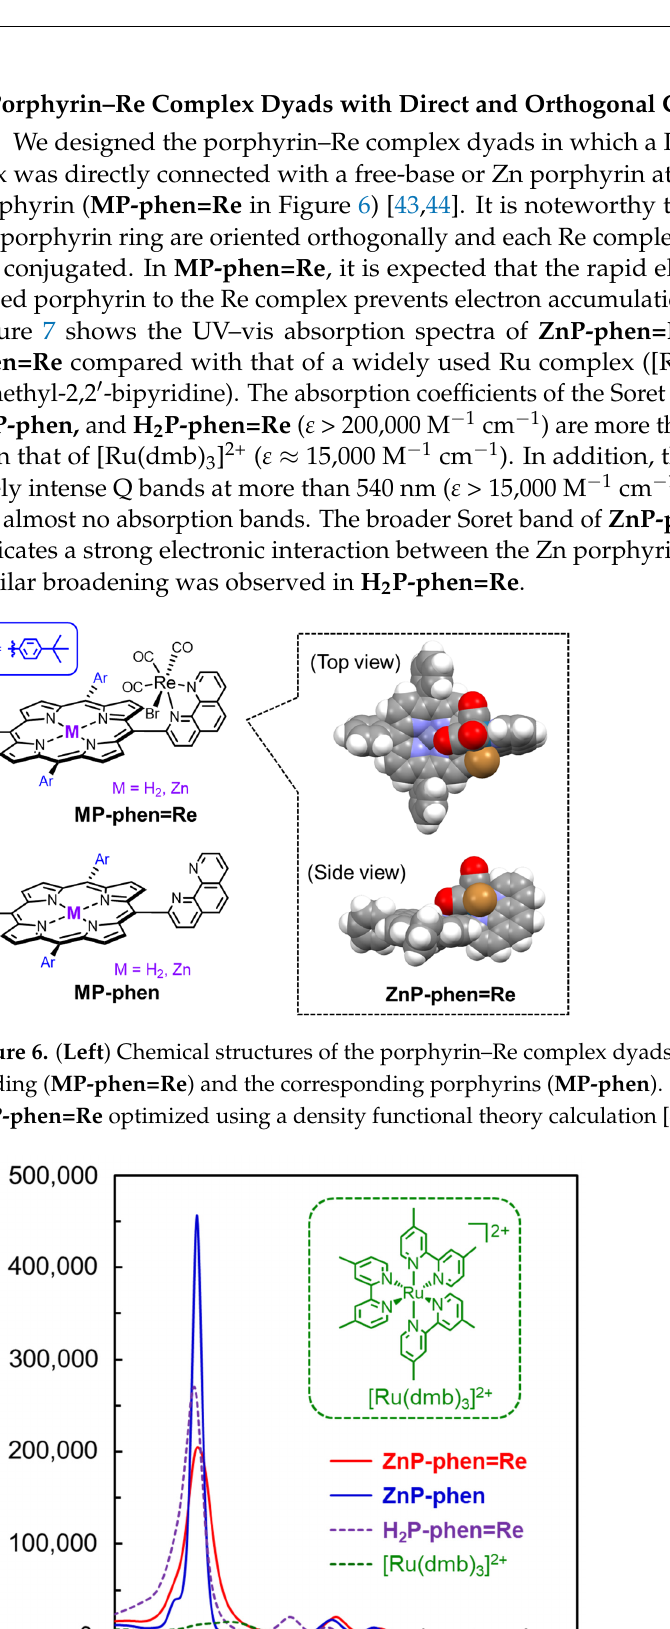
Figure 5. Electrochemical reduction of ZnTPP [39] and formation of chlorin [41,42]. The redox po- tentials are denoted with respect to an aqueous SCE [39]. The numbers in nm are peak wavelengths of UV–vis absorption spectra.